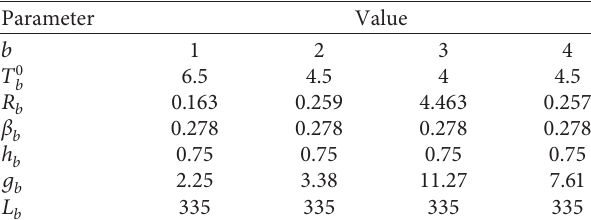
Table 3: Parameter settings for different types of